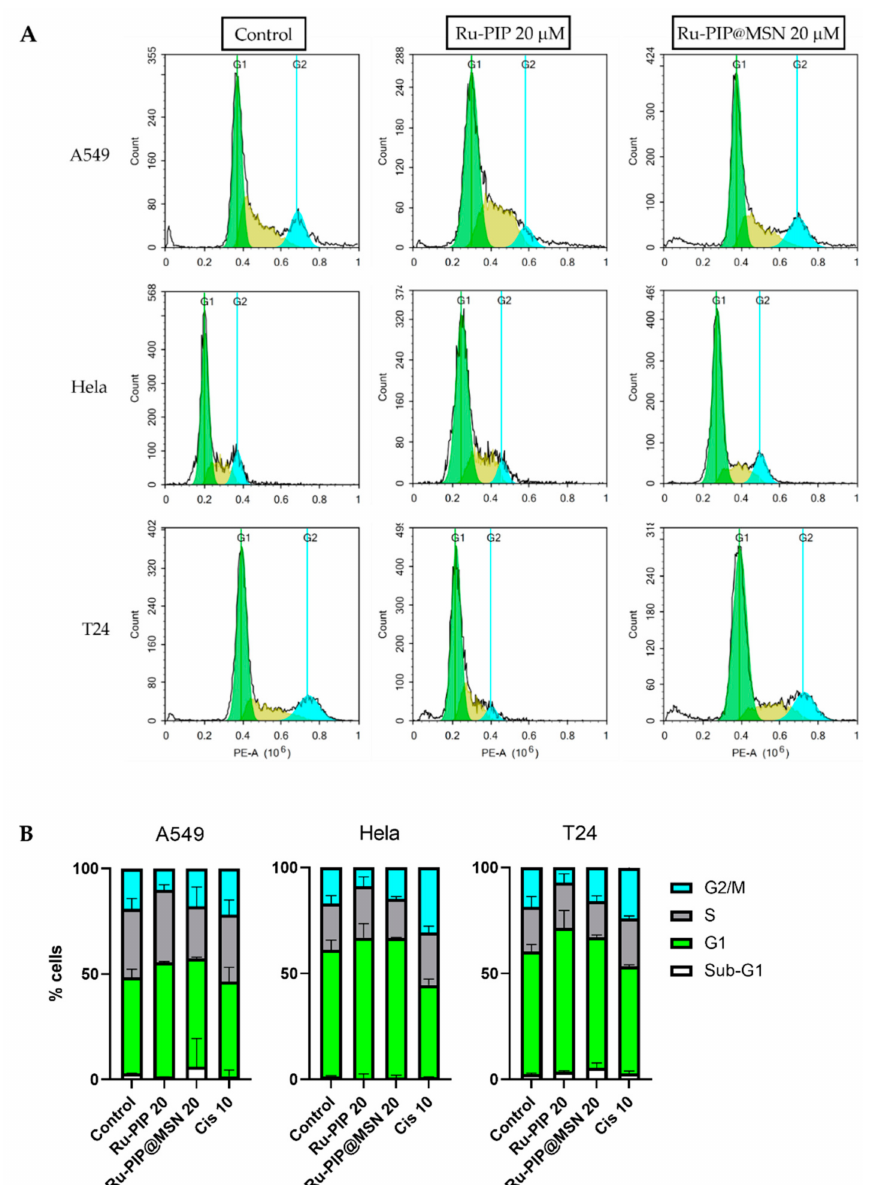
Figure 8. Cell cycle analysis of A549, Hela, and T24 cells. ( A ) DNA histograms depict the cell cycle distribution of Ru-PIP (20 µ M) and Ru-PIP@MSN (20 µ M) treatments compared to control cells. ( B ) Quantification of cell cycle distribution. Treatment with cisplatin (10 µ M; Cis 10) are included for